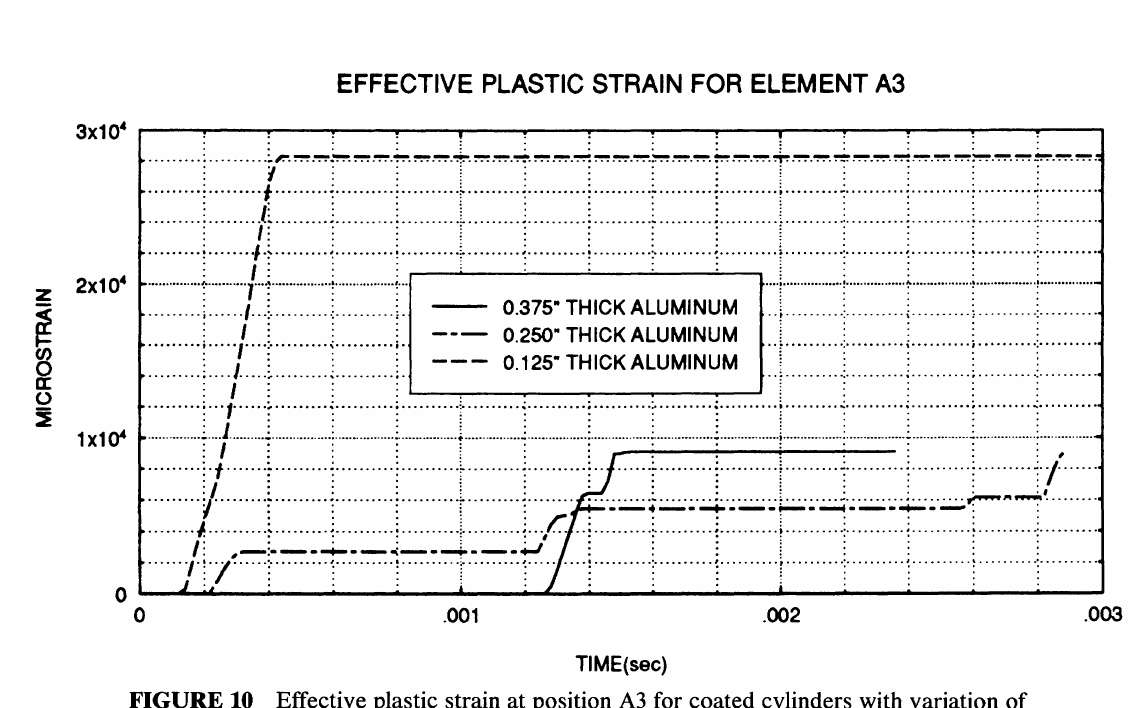
FIGURE 10 Effective plastic strain at position A3 for coated cylinders with variation of aluminum shell